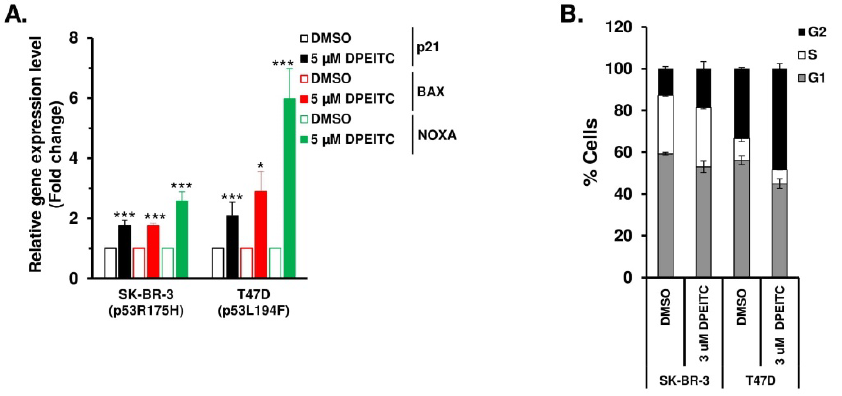
Figure 6. DPEITC reactivates different p53 mutant proteins’ transactivational functions and induces G2 phase arrest in HER2+ and Luminal A breast cancer cell lines. ( A ) SK-BR-3 (p53 R175H ) and T47D (p53 L194F ) cells were treated with DMSO or 5 µ M DPEITC for 3 h, and qRT-PCR of p53 regulated genes was performed. (*** p ≤ 0.0001 and * p ≤ 0.03). ( B ) SK-BR-3 (p53 R175H ) and T47D (p53 L194F ) cells were treated with DMSO or 5 μM of DPEITC for 72 h and analyzed by flow cytometry. Experiments were performed in triplicate. Error bars represent SD.